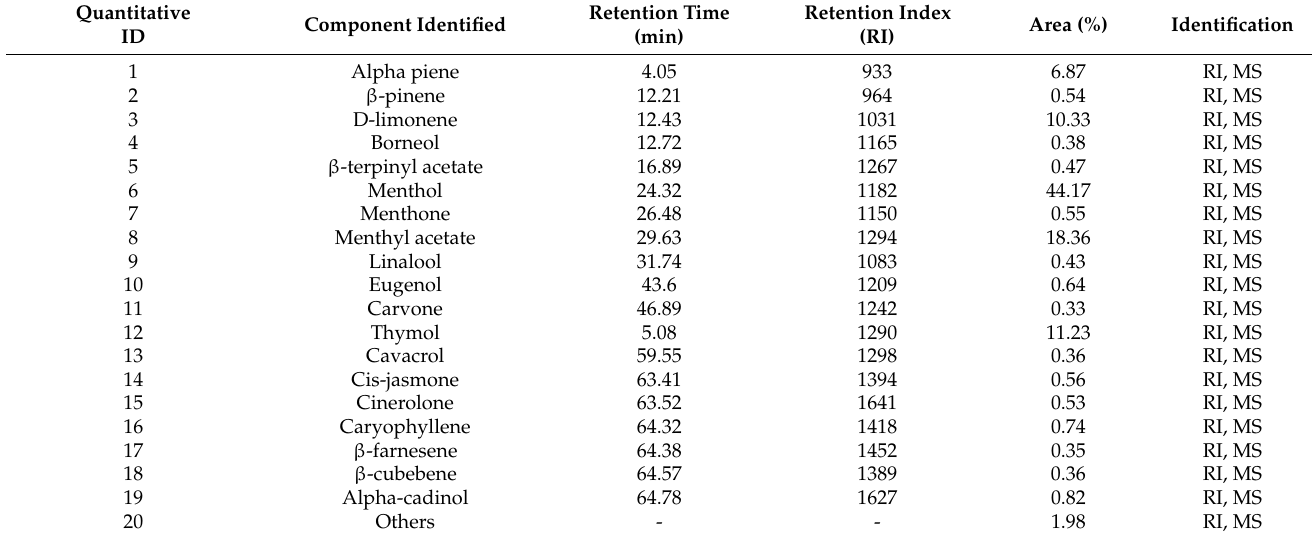
Table 2. The relative percentage of the area of peak M. longifolia EO